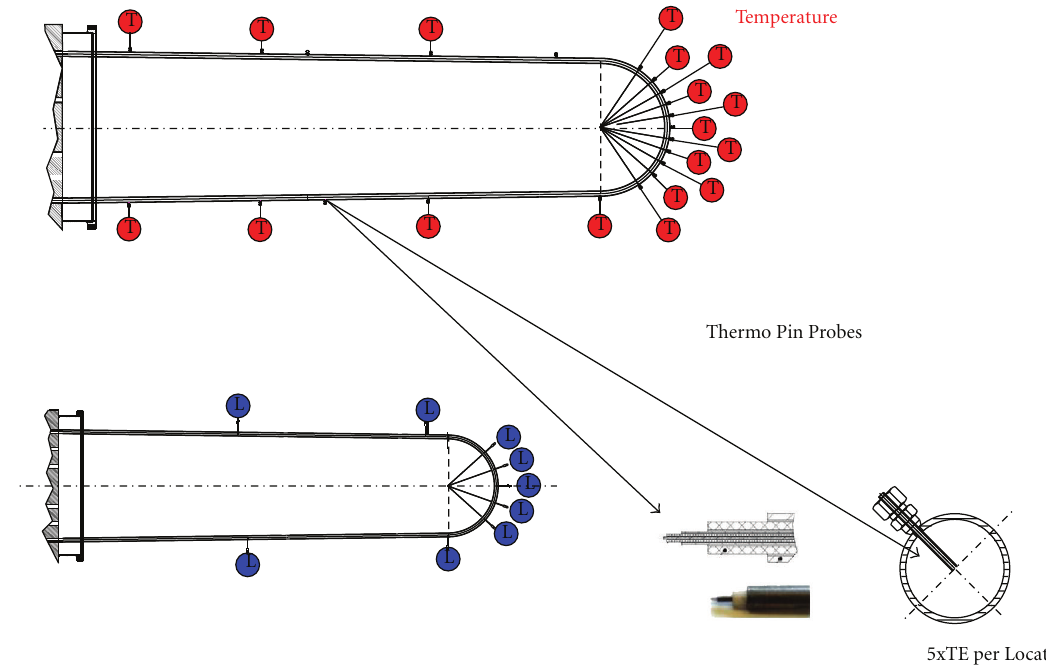
Figure 12: Instrumentation of the Emergency Condenser